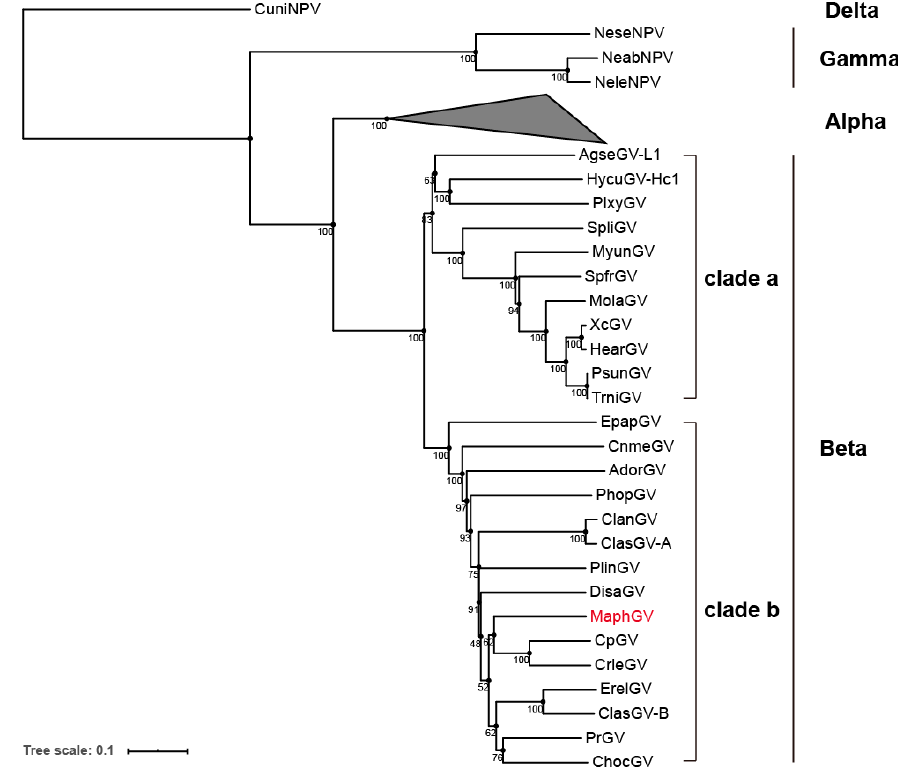
Figure 3. Phylogenetic tree inferred from concatenated predicted amino acid sequences of 38 conserved core genes of 108 sequenced baculovirus genomes. The unrooted tree was generated using the minimum evolution method with 1000 bootstrap values. MaphGV is highlighted in red. Branches of the genera Alphabaculovirus are collapsed. Taxon genera are indicated behind corresponding branches. Both clades a and b of Betabaculovirus are indicated in brackets.